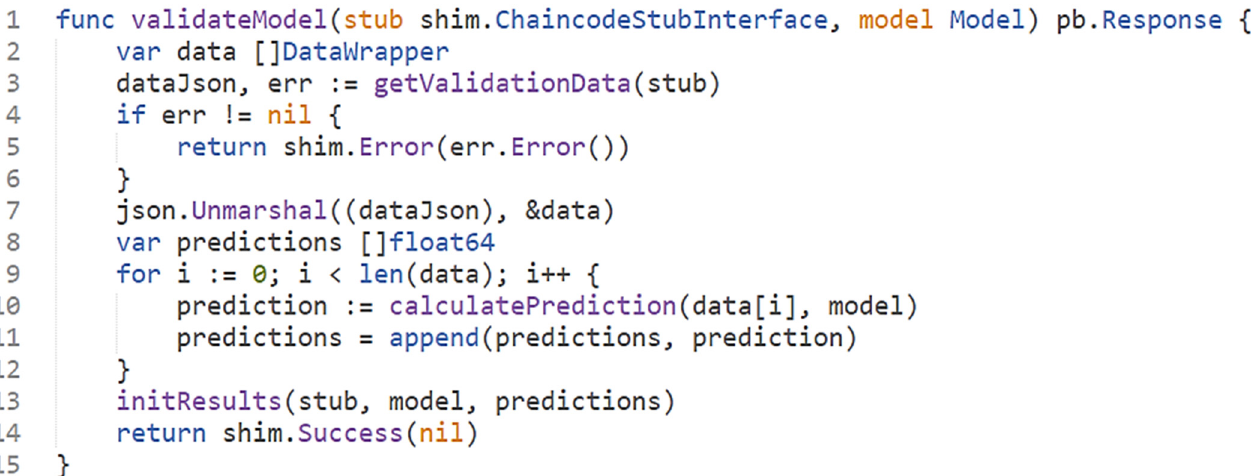
Figure 5. Validate model function: Chaincode fragment of the smart contract.